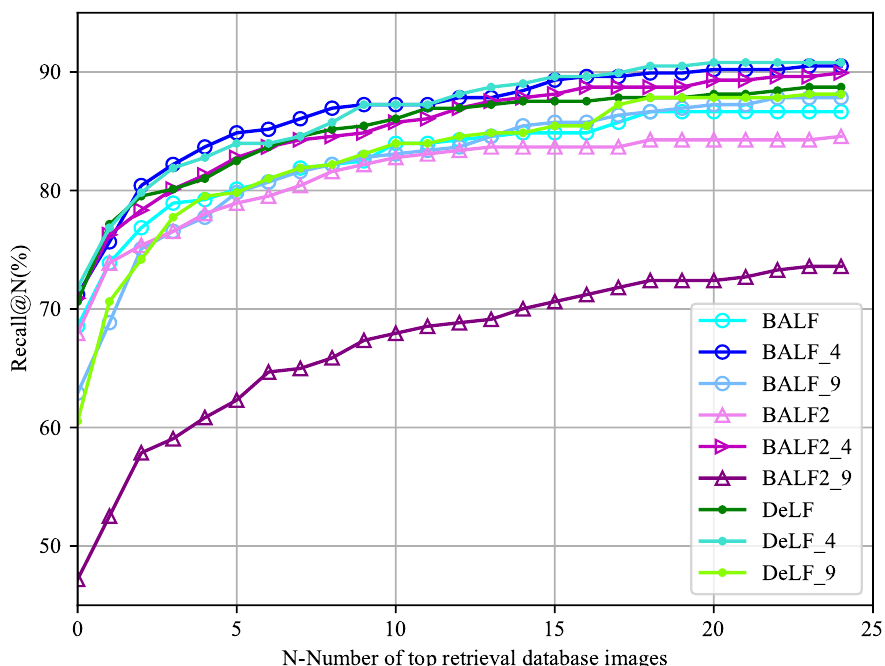
Figure 11. Positioning effect of all experiments measuring ny Recall@N. Both BAF and patch-region retrieval show good